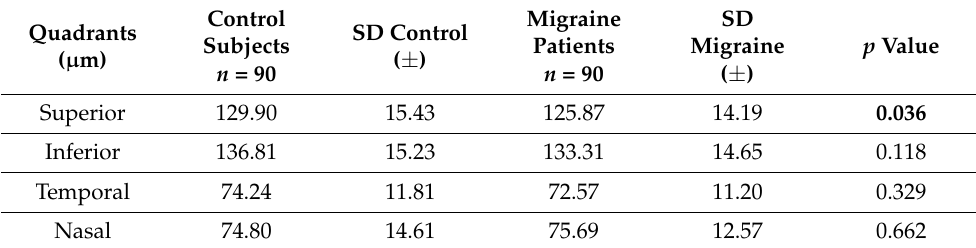
Table 5. Peripapillary RNFL thickness ( µ m) in each of the 90 ◦ quadrants around the optic disk.